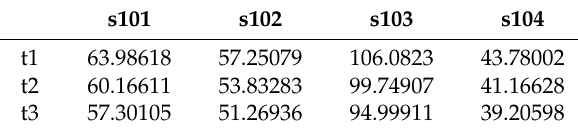
Table A18. Demand load on bus s (MW): d( t , s ).